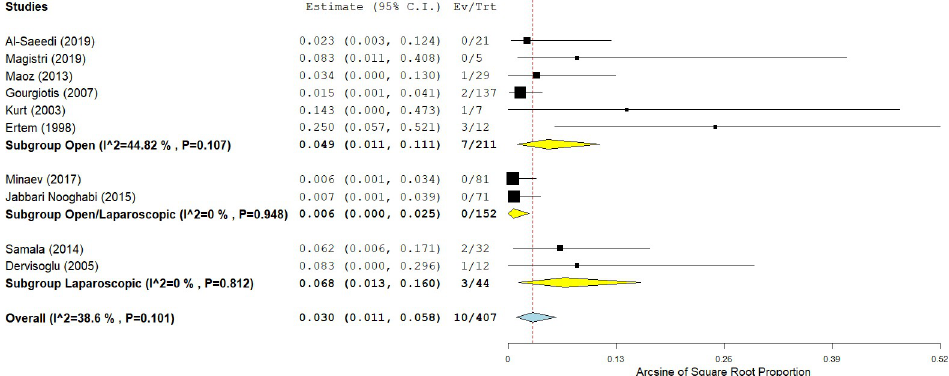
Fig 2. Forest plot of the intraoperative complications rate in endocystectomy for cystic echinococcosis, with subgroup analysis of laparoscopic and open surgeries.